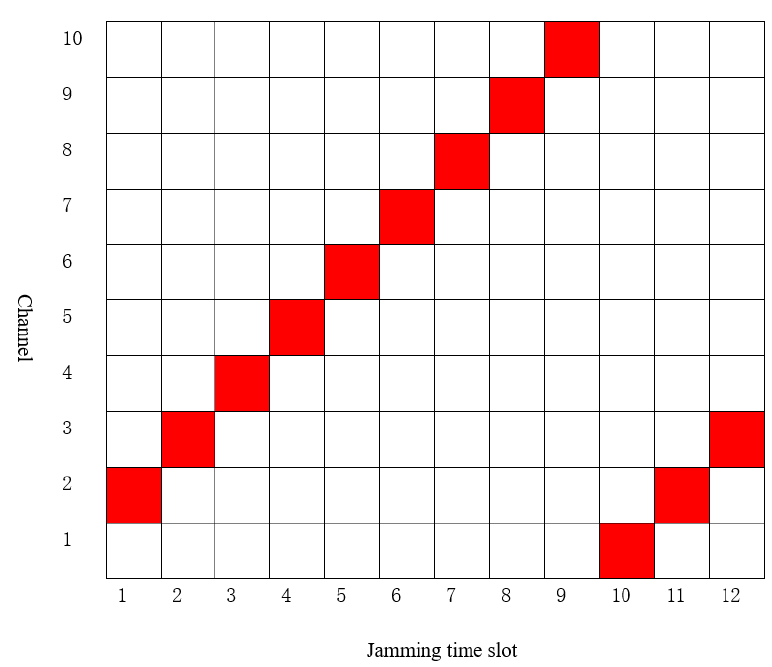
Figure 5. Linear sweep jamming distribution.